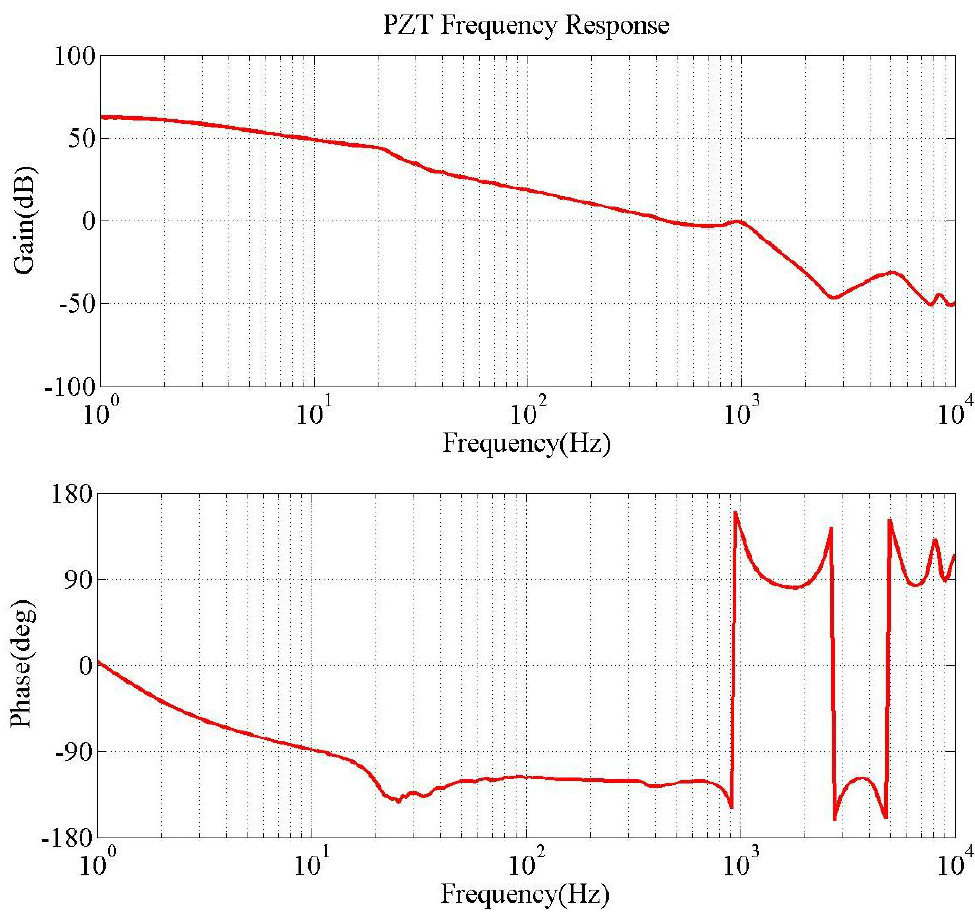
Figure 10. Measured frequency response of optimum PZT